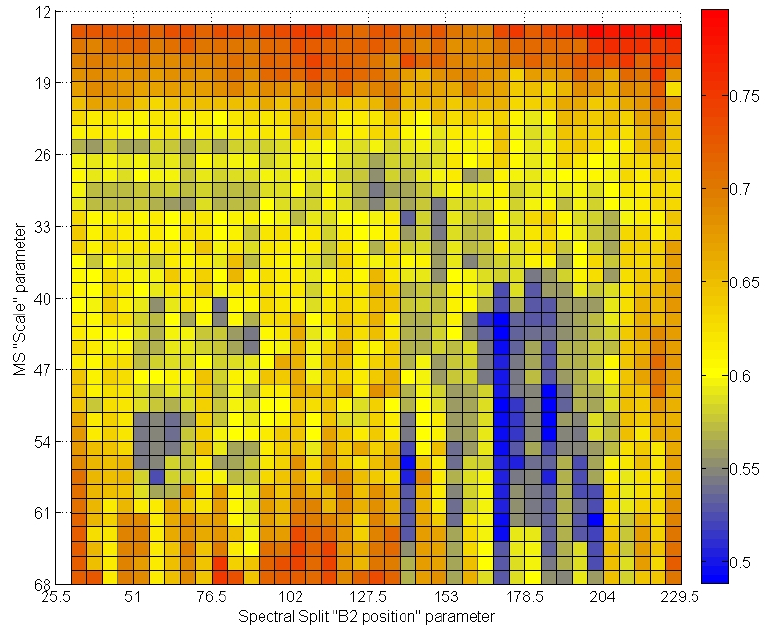
Figure 3. Two dimensions (band position 1 and scale parameters) of the seven dimensional search space of the parameter set depicted in Figure 2 (average of 15 reference segments) using the Reference Weighted Jaccard (RWJ) metric (Section 2.5).